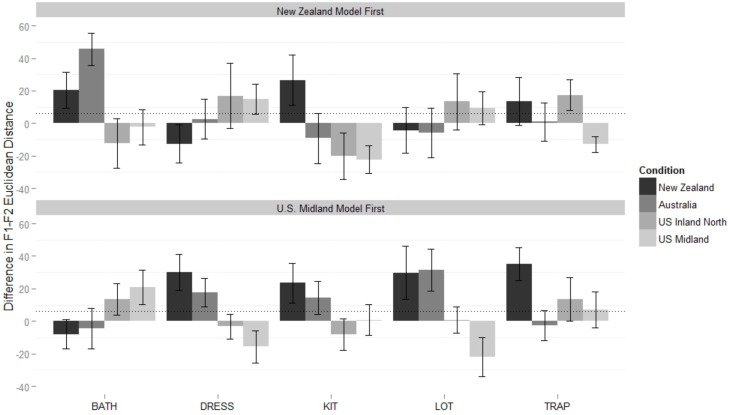
Midland participants' difference in Euclidean distance from models on monophthongs, from baseline reading to shadowed reading. Values at zero represent no shift, positive values a shift toward the model, and negative values a shift away from the model, compared to the baseline. Top panel: When participants begin with the New Zealand block. Bottom panel: When participants begin with Midland block. Error bars mark 95% confidence intervals. Dotted line represents grand means of models.